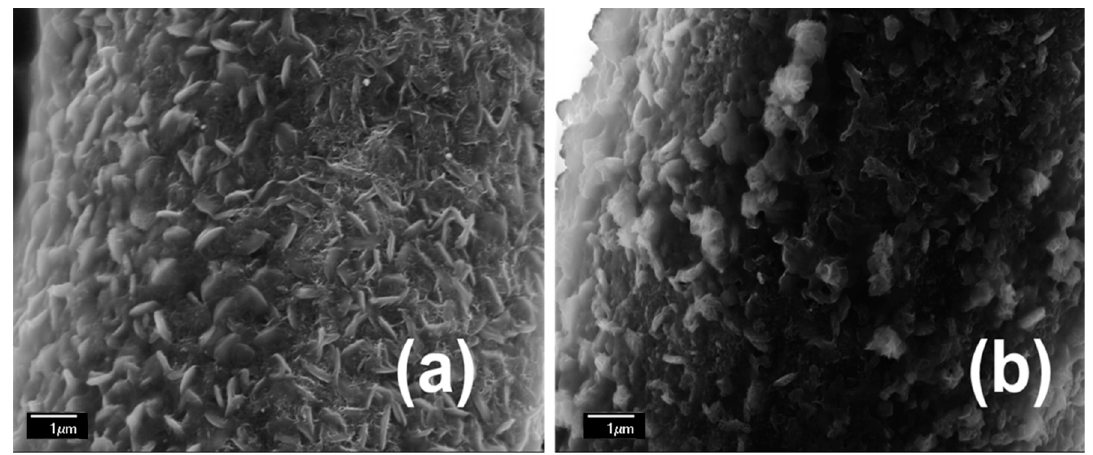
Figure 7. SEM images after cycling of ( a ) PF- and ( b ) PC-CNT cathodes.